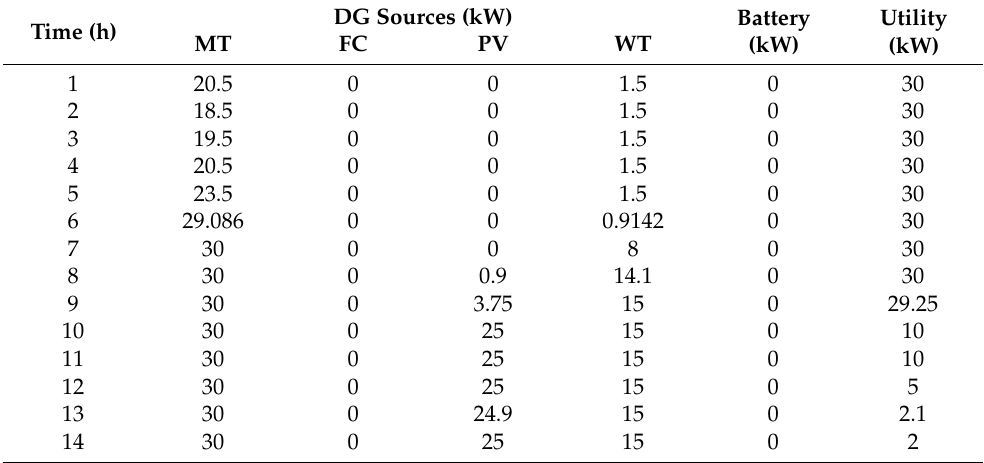
Table 8. Economic dispatch for Scenario